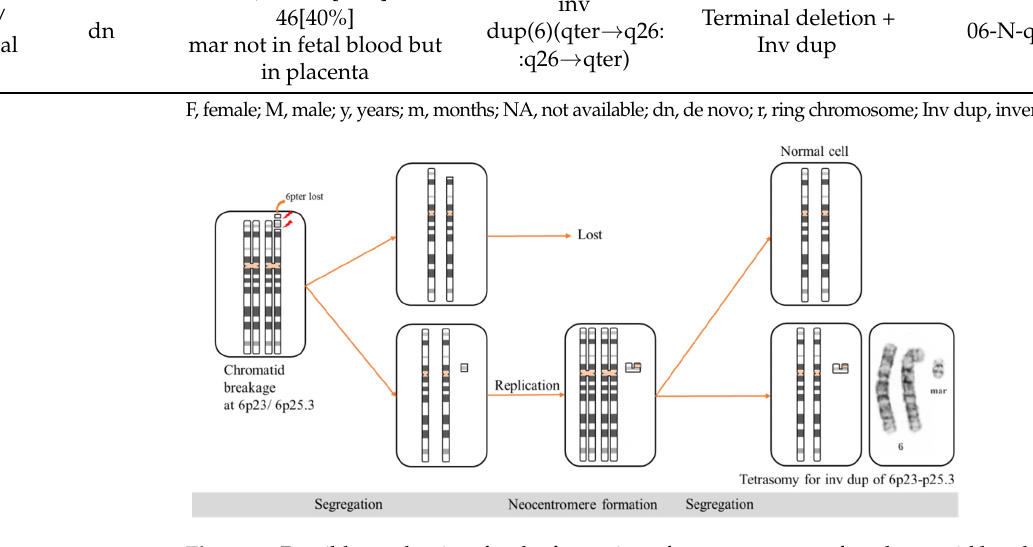
Figure 3. Possible mechanism for the formation of neocentromere after chromatid breakage at mitosis. After chromatid breakage, the acentric fragment of 6p23-p25.3 underwent segregation and subsequent replication. The broken ends of the fragment rejoin to create the inverted duplication, leading to formation of neocentric sSMC. The neocentric sSMC segregates with its sister chromatid, resulting in mosaic tetrasomy for 6p23-p25.3. (Centromeres shown in light orange). Pure partial trisomy 6p is very rare and can be caused by tandem duplications, in- verted duplications, a supernumerary marker chromosome, interchromosomal insertions, and unbalanced chromosome rearrangements [11]. The proximal breakpoint in the short arm of chromosome 6 can vary from 6p11 to p25 and the clinical severity varies even within the same family with the same duplicated segments [10]. The typical characteristic features include low birth weight, developmental delay, growth retardation, mild to severe craniofacial abnormalities, feeding difficulties, recurrent infections, neurological anoma- lies, congenital heart defects, and renal abnormalities [4,10,14]. To our knowledge,